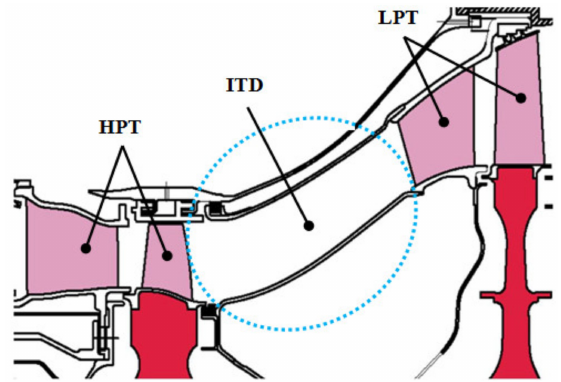
Figure 1. Typical ITD in a turbofan